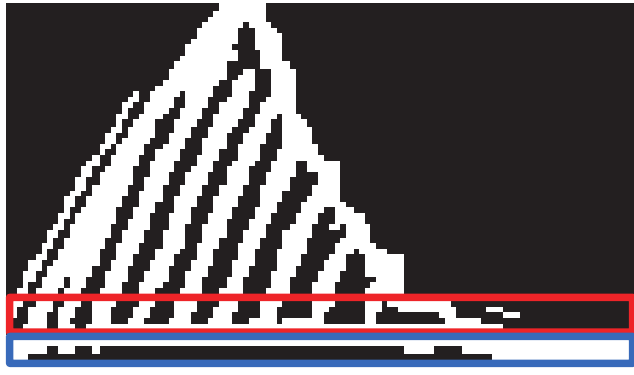
Figure 9. Binarized image of the first dorsal fin. White pixels indicate the spines. The region surrounded by the red rectangle was used for histogram construction.